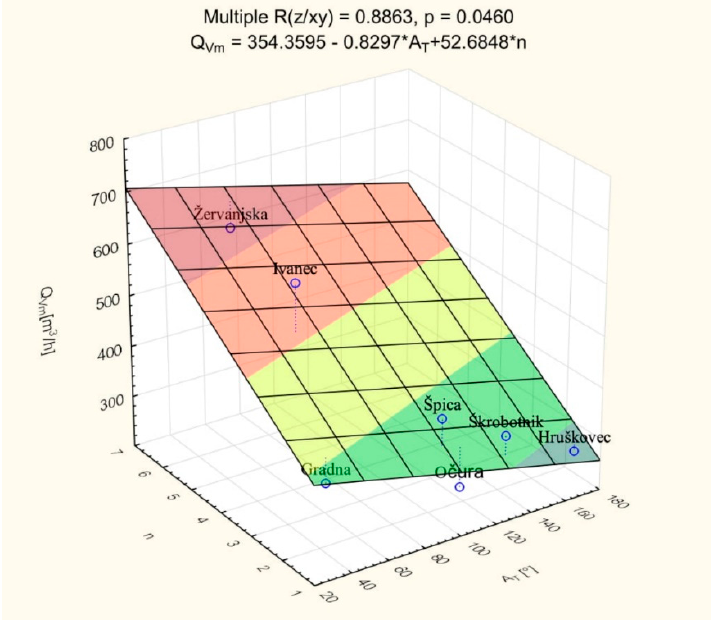
Figure 8. Multiple regression analysis of the dependence of the excavator productivity on the slew angle of the excavator and the coefficient of uniformity of the particle size distribution. Table 6. Regression summary for dependent variable Q V .